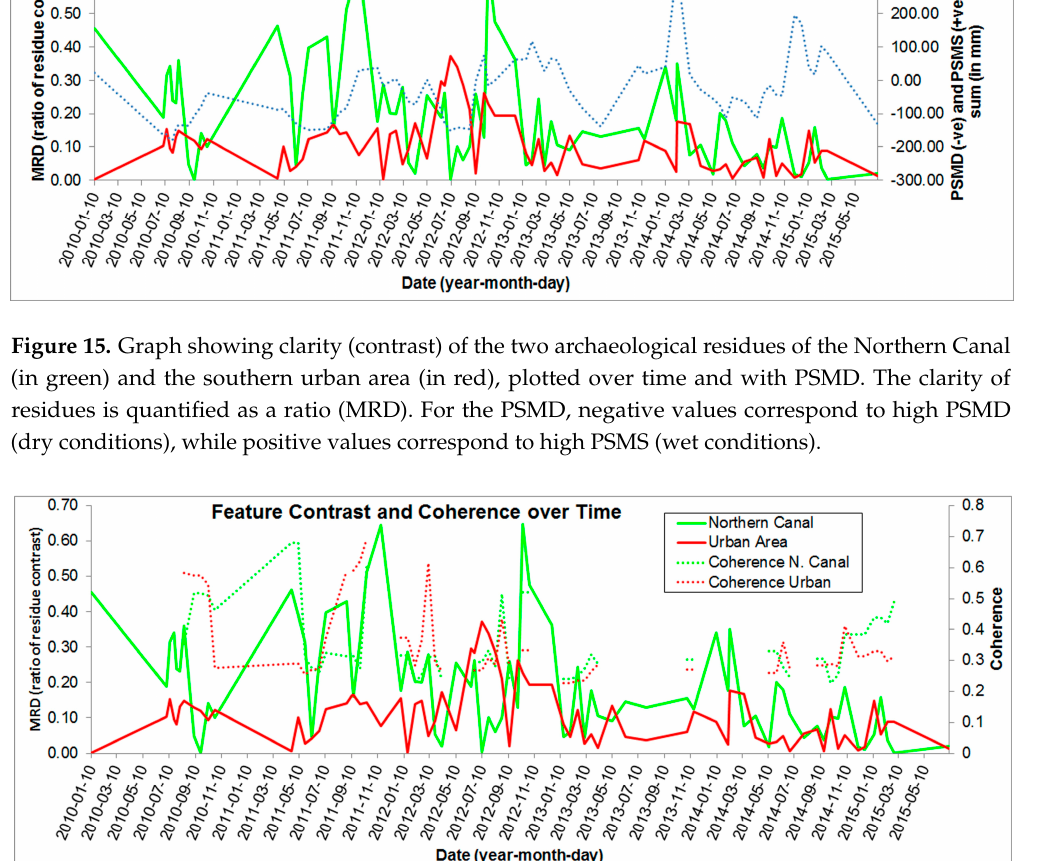
Figure 16. Graph showing contrast, quantified by means of MRD, of the two archaeological residues of the Northern Canal (in green) and the southern urban area (in red), plotted with their respective coherences (dotted lines) over time. The coherence values are provided both for the master and the slaves of InSAR pairs. Where a master is also a slave, it takes the value of the slave.